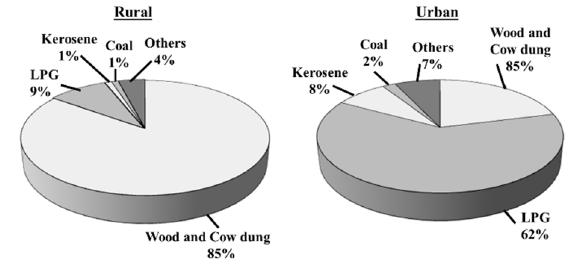
Fig. 1 Distribution of cooking fuels for rural and urban households in India (NSSO, 2010, Ref.